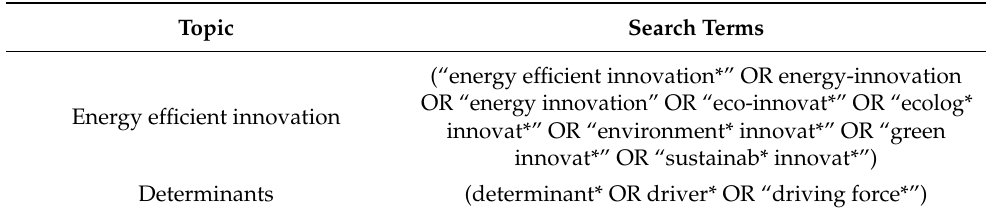
Table 1. Search terms used in the literature review of determinants of energy efficient